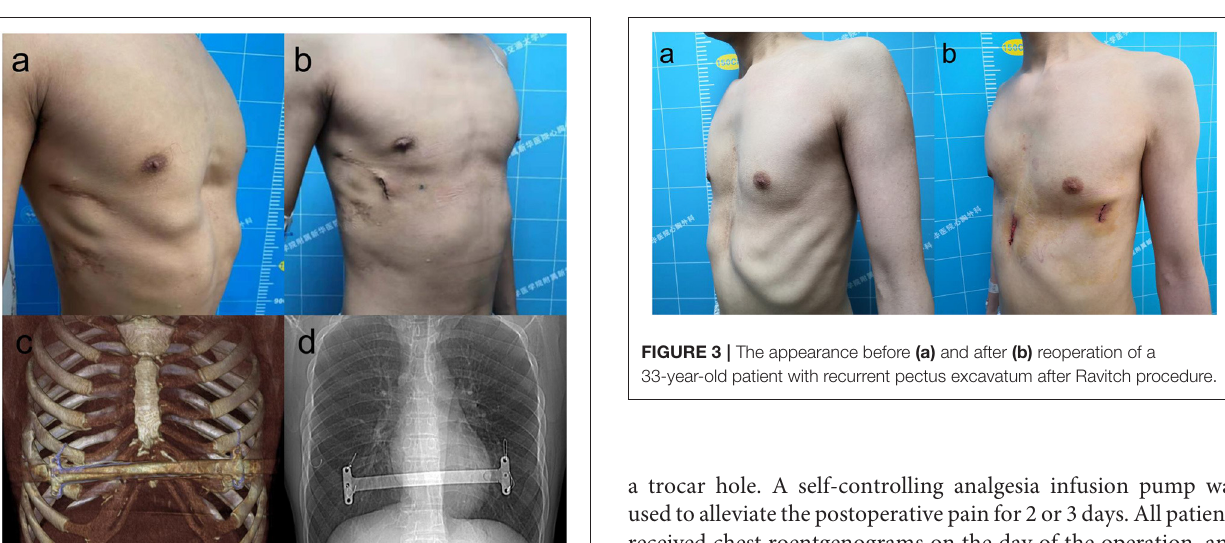
a trocar hole. A self-controlling analgesia infusion pump was used to alleviate the postoperative pain for 2 or 3 days. All patients received chest roentgenograms on the day of the operation, and complications such as pneumothorax and pleural effusion. were recorded. All patients were followed up for 3 months after the chest CT. Patients were advised to have the bar removed 3